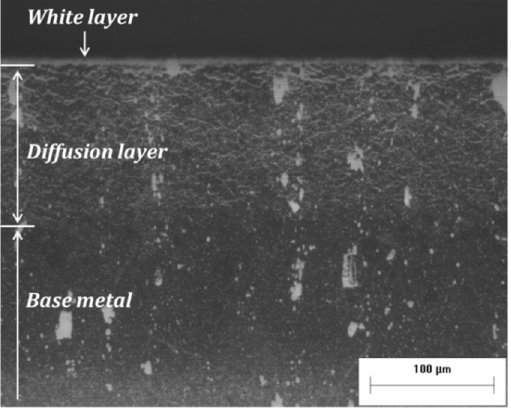
Figure 7. Representative cross-section of a tool steel subjected to Tufftriding (optical micrograph).